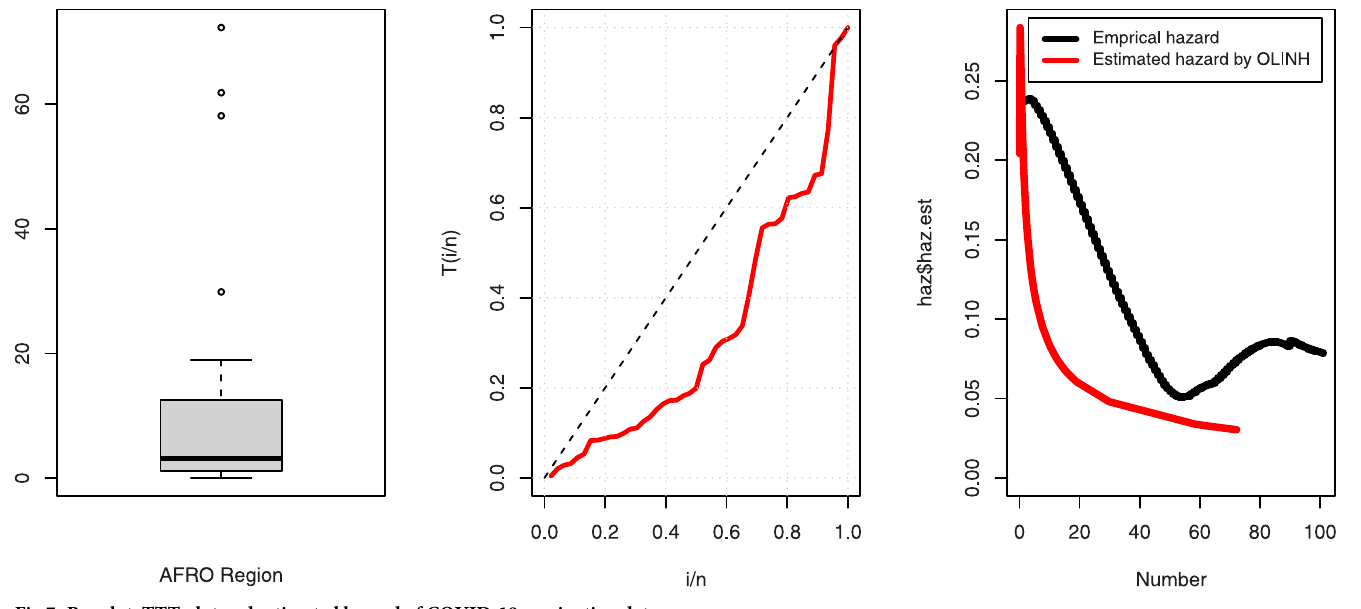
Fig 7. Boxplot, TTT plot and estimated hazard of COVID-19 vaccination data.